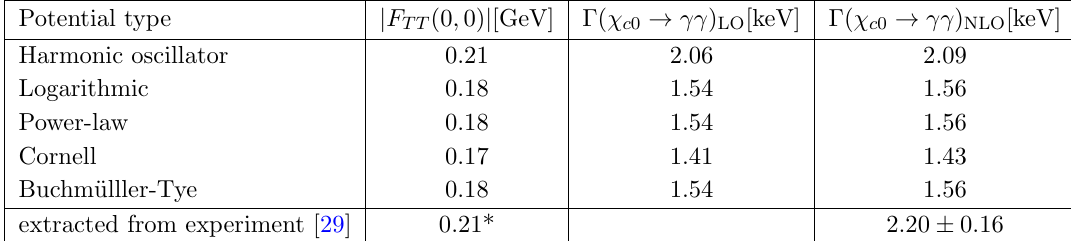
Table 3 . F TT (0 ; 0) with m c = 1 : 27 GeV and corresponding radiative widths. Potential type